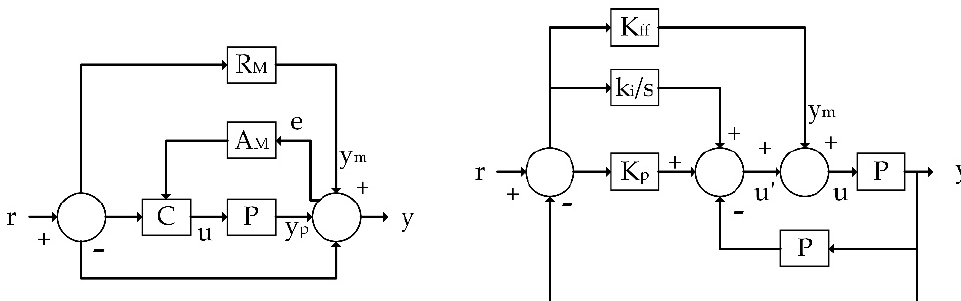
Figure 2. Model Reference Adaptive Control Scheme (left) PIV-FF scheme (right).